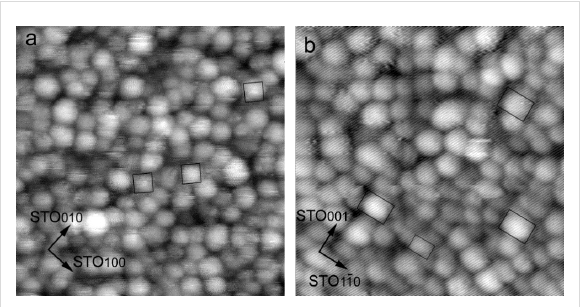
Figure 3: STM images of Fe nanoparticles on a) STO(001) (30.2 nm 2 , V sample = +1.2 V, I = 0.2 nA), and b) STO(110) (21.5 nm 2 , V sample = +1.5 V, I = 0.3